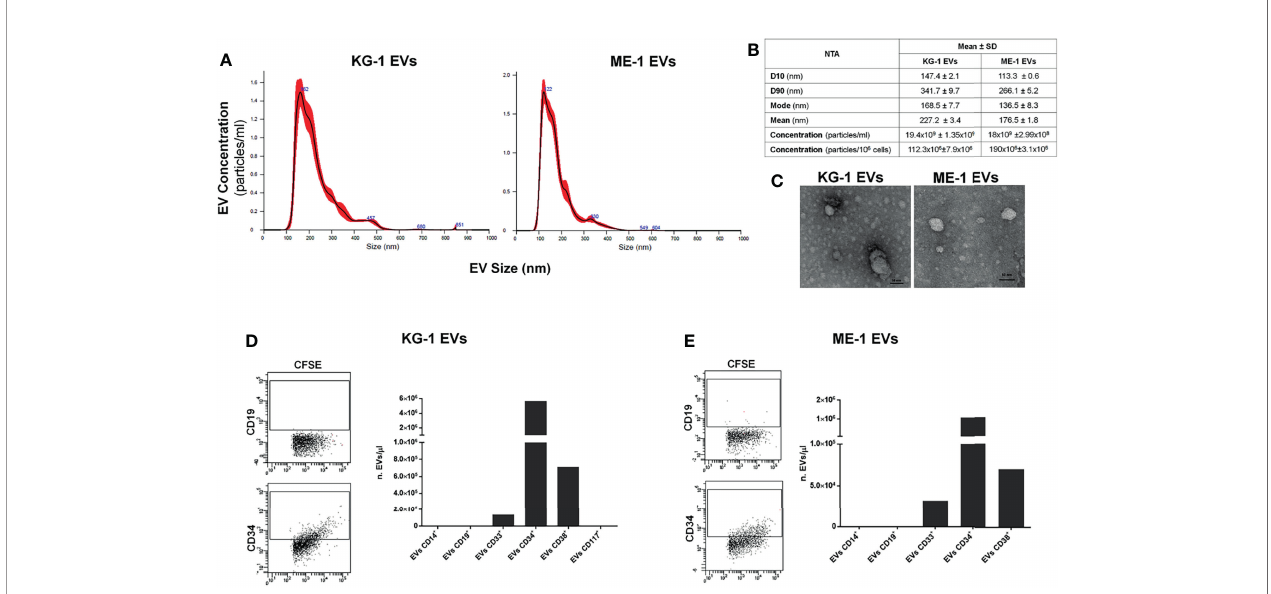
FIGURE 1 | AML EV characterization. (A) Representative histograms of hydrodynamic size distribution pro fi le of EVs from KG-1 and ME-1 cell lines measured by NTA. (B) NTA data are expressed as D10, D90, mode, mean and concentration (particles/mL and particles/1x10 6 cells) as mean value ± standard error of AML derived-EVs. (C) Representative TEM images of AML cell line derived-EVs (image magni fi cation: 100kX); horizontal bar indicates 50 nm. (D, E) Quanti fi cation as EV number for µL (nEVs/µL) of CD14 + , CD19 + , CD33 + , CD34 + , CD38 + and CD117 + EVs produced by KG1 and ME-1 cells. Representative cytometric dot plots of AML derived-CFSE + EVs labeled for anti-CD19 and anti-CD34 surface markers were